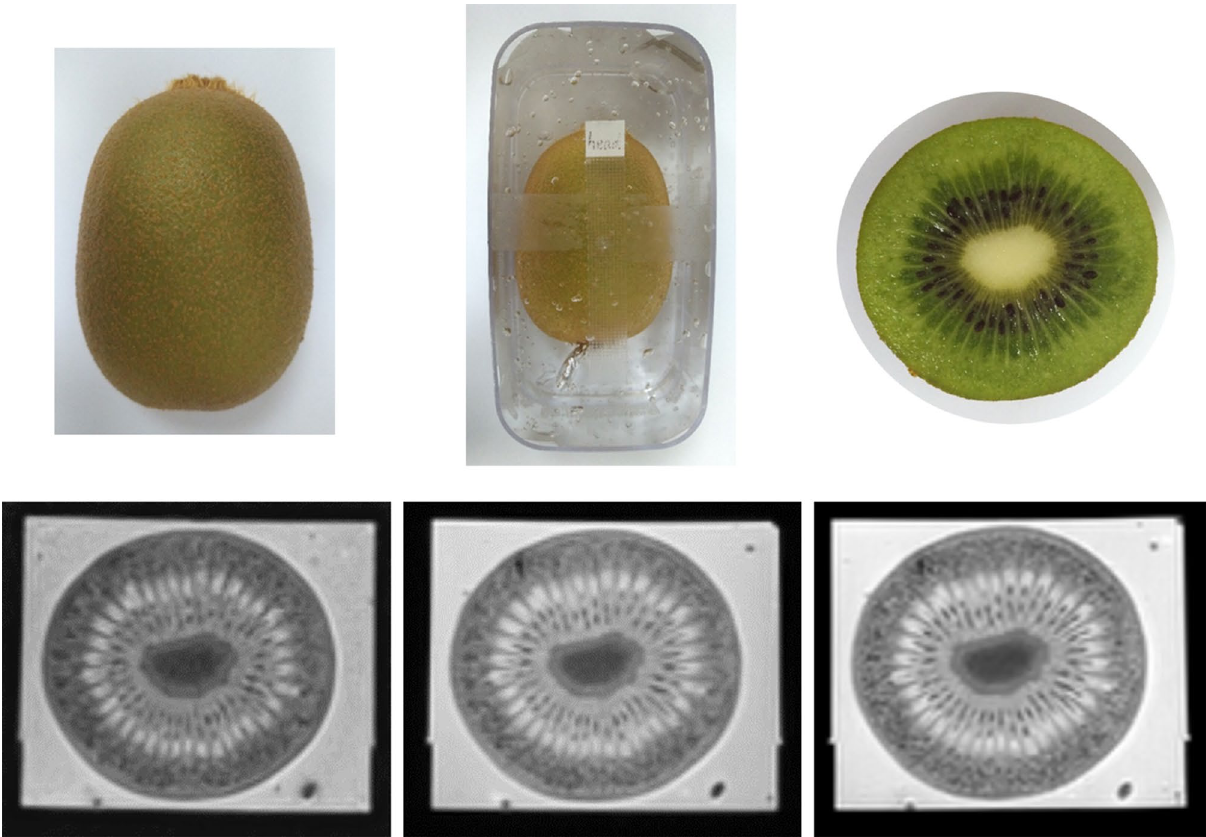
Figure 3. Kiwi phantom. Note Remove the hair of the green kiwi firstly, and then keep it in ultrasound gel within a tough plastic box of suitable size. T2 weighted images of a kiwi from three 3-T MR scanners are displayed below (Siemens, GE and Philips, respectively). Their scanning parameters were: 3000 ms (repetition time), 80 ms (echo time), 5 mm (slice thickness), 350 × 350 (field of view), 256 × 256 (acquisition